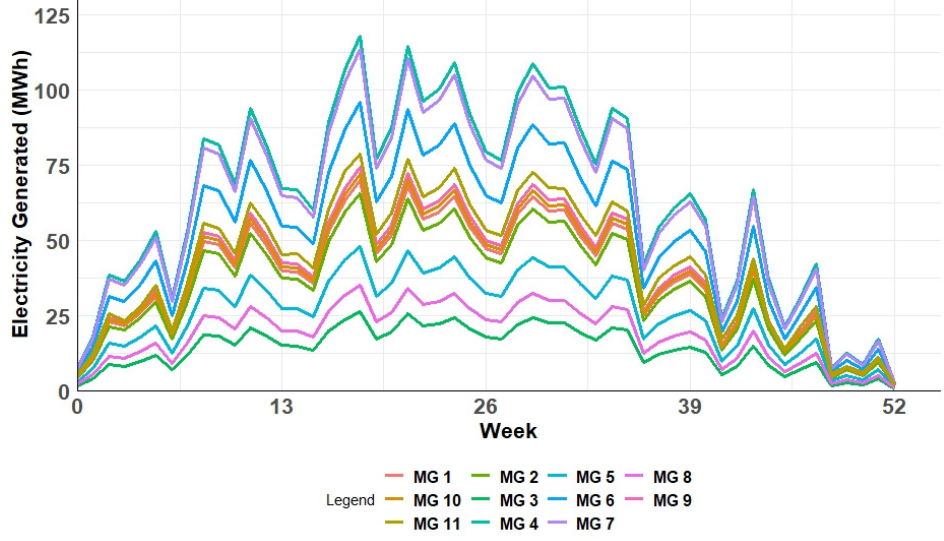
Figure 9. Weekly solar energy (MWh) generated at each microgrid over a one-year time period.